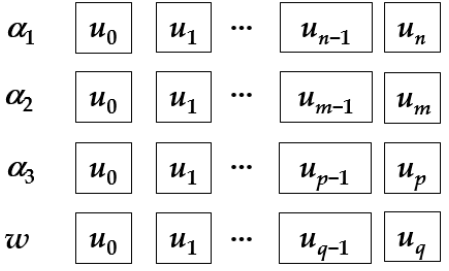
Figure 4. Dimensions of different individuals.